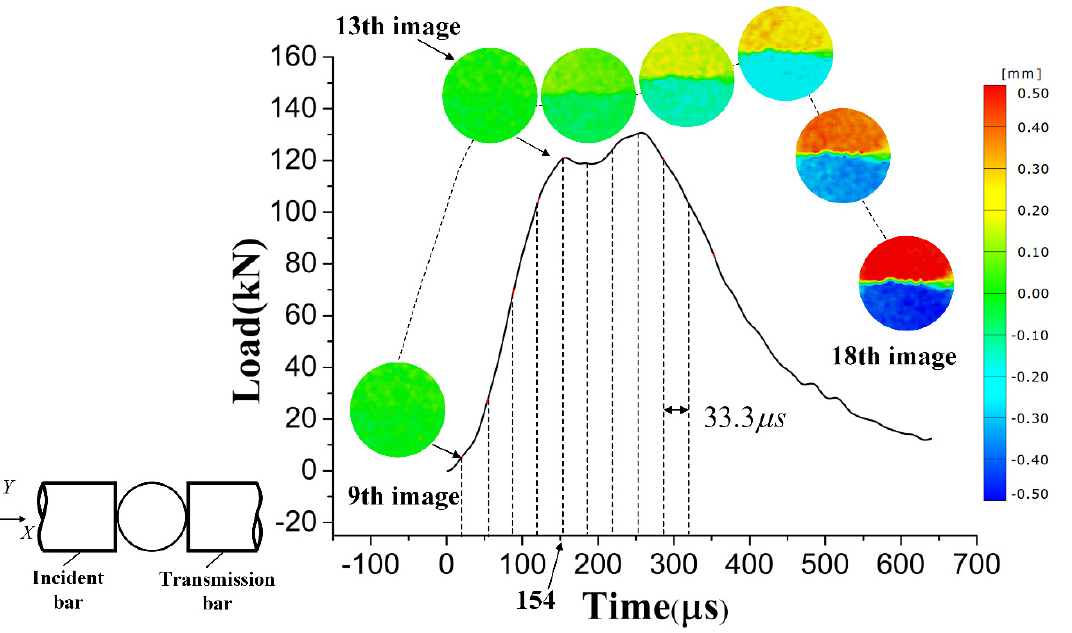
Figure 9. The relation between the images from the high-speed camera and the load–time curve with a turning point.